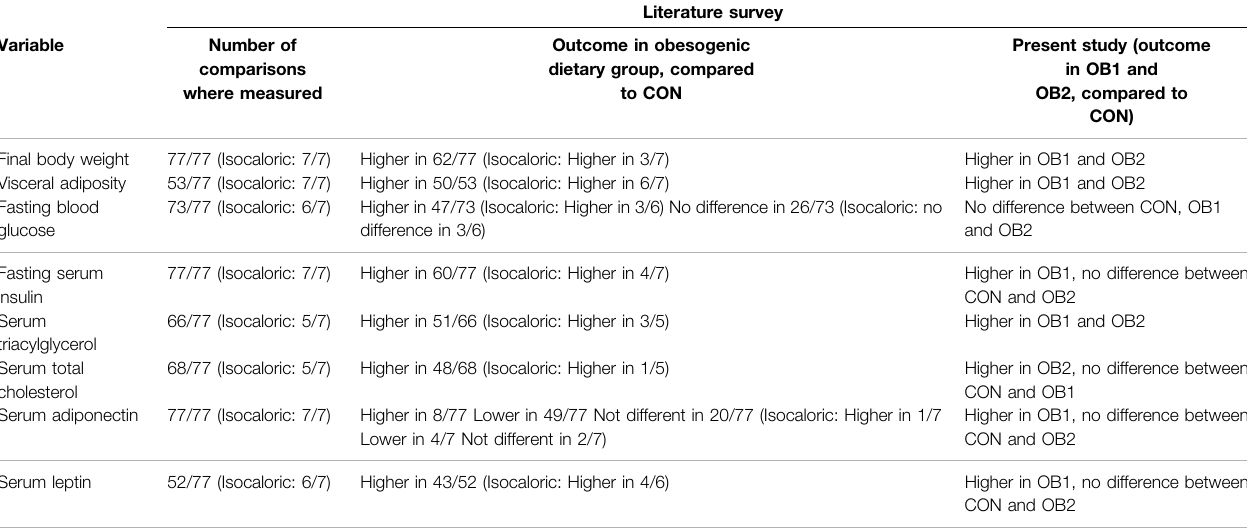
TABLE 3 | Summary of results of literature survey and comparison with present fi